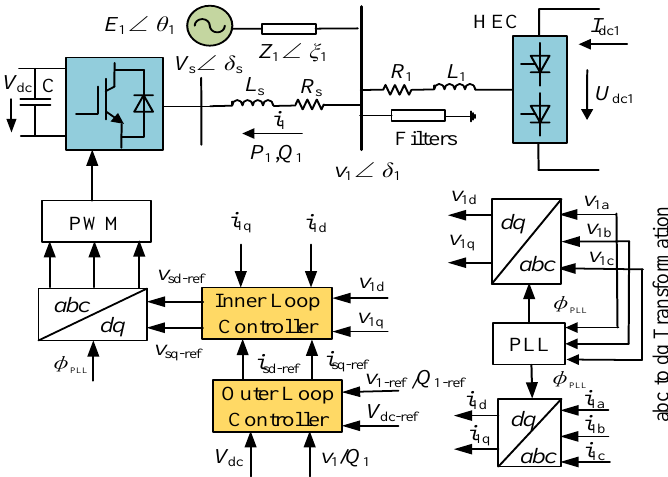
Figure 3. Single line diagram of the STATCOM with its basic control approach.